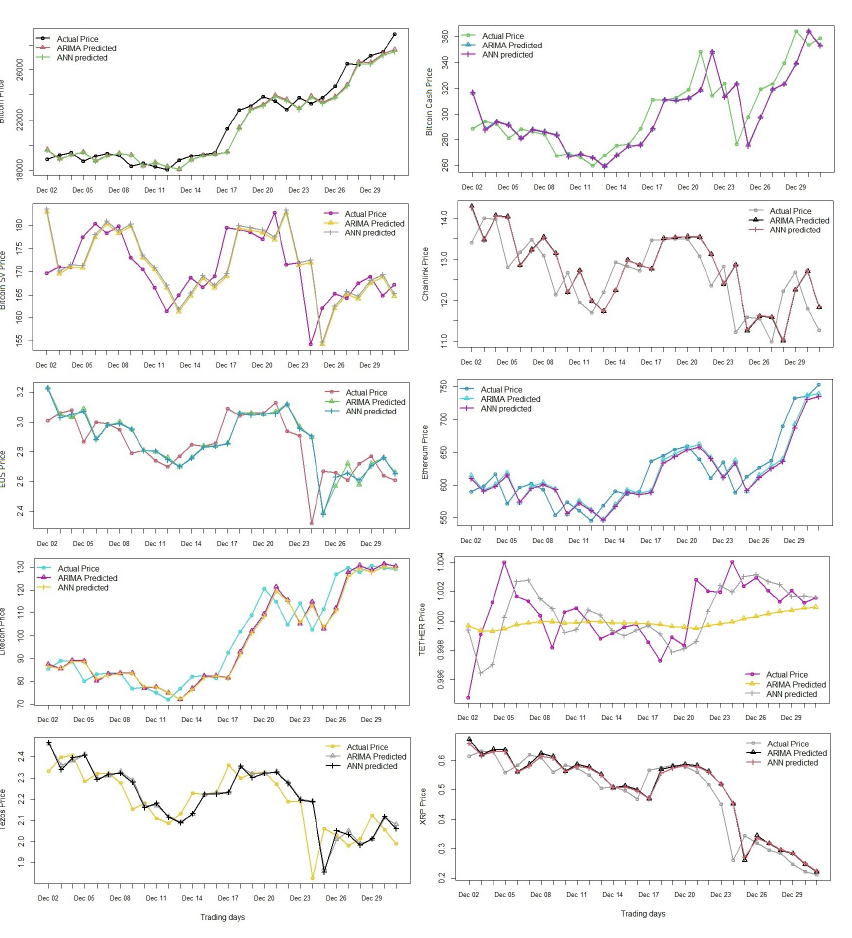
Figure 11. Comparison between market prices versus ARIMA and ANN predicted